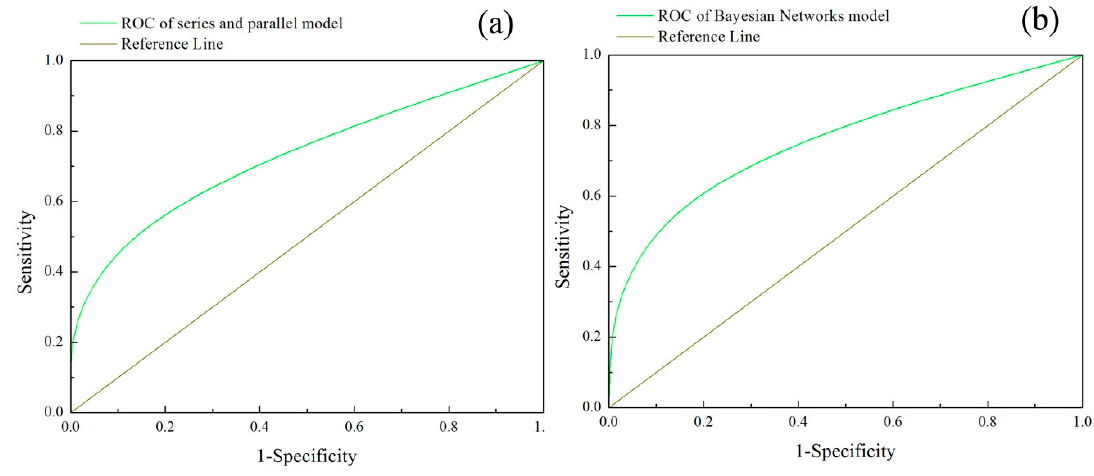
Figure 9. The ROC curve of the susceptibility assessment results for ( a ) The series and parallel model, ( b ) The Bayesian Networks model.